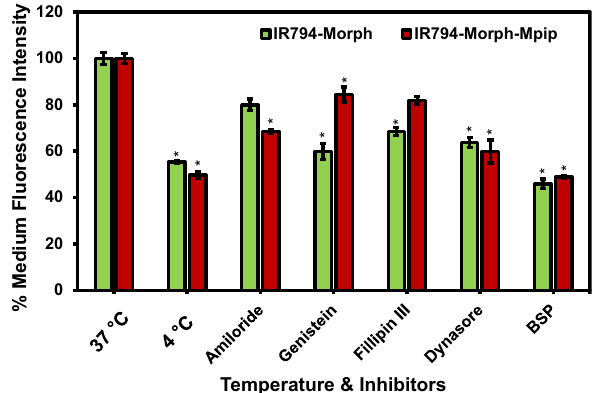
Figure 9. Flow cytometry of HepG2 cells incubated with 1 μM of IR794 for 15 min in culture media. Cellular trafficking pathway of IR794-Morph and IR794-Morph-Mpip characterised by various inhibitors and at 4 °C condition. The endocytosis inhibitors used include amiloride (micropinocytosis), genistein (caveolin-mediated), Fillipin III, dynasore (clathrin-mediated) and BSP. Data reports as % Medium fluorescence intensity and represents the mean ± SD (n = 3, independent experiment). Statistical analysis is based on Pair Student’s T-test analysis (*P < 0.05, **P < 0.01, ***P < 0.001) where the comparison between the uptake at 37 °C and the uptake in the presence of different inhibitors is marked.